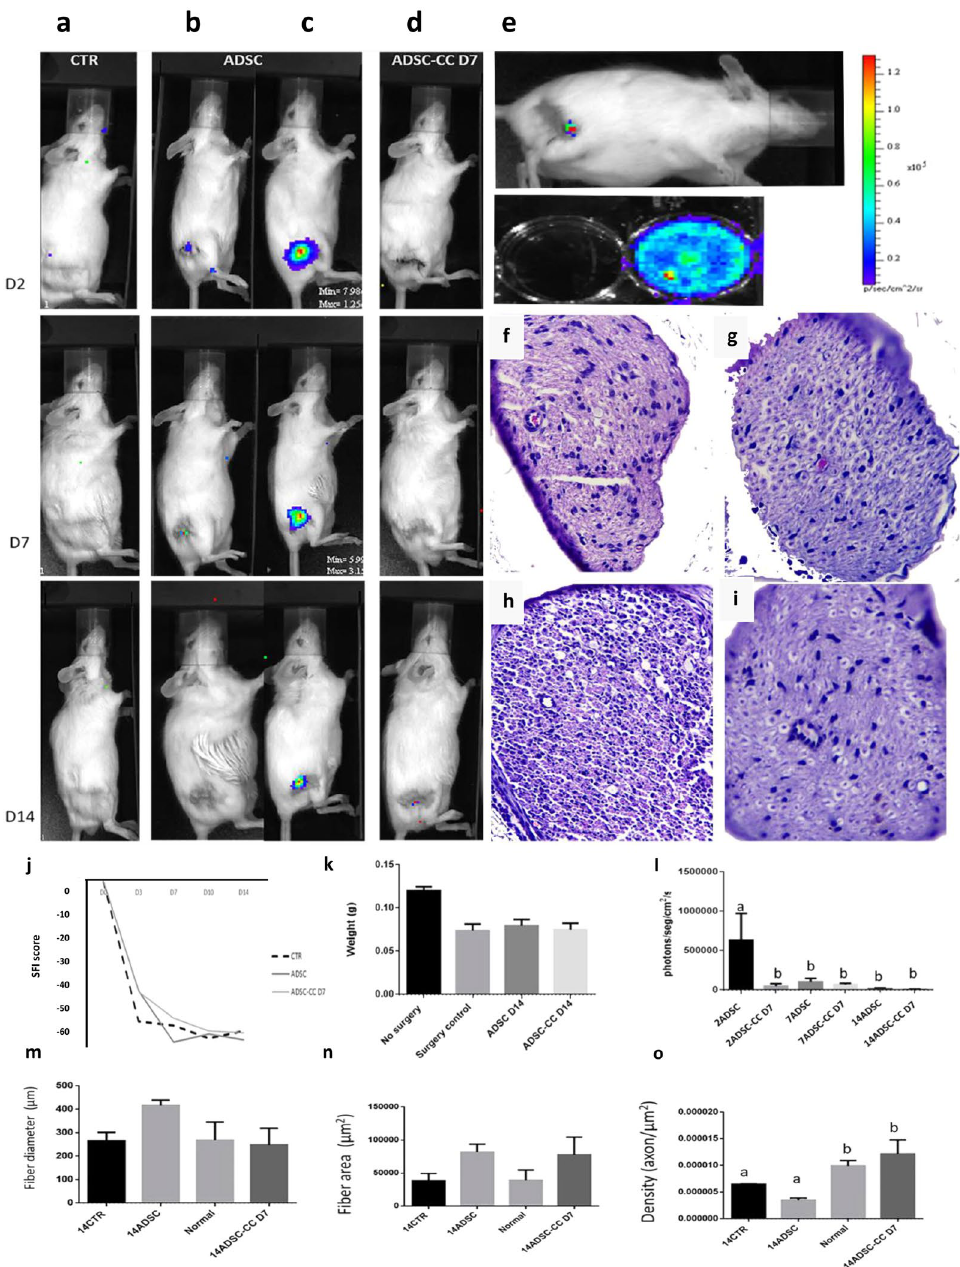
Figure 4. Co-cultured ADSC local environment improvement in vivo . ( a ) Example IVIS analysis of the CTR (control group) surgery without stem cell application group. ( b , c ) Example IVIS analysis of the surgery with ADSC application group. ( d ) Example IVIS analysis of the surgery with ADSC-CC D7 application group. ( e ) ADSCs-CC D7 were bioluminescent after the differentiation process, and after the application, few bioluminescence was acquired. Signal close to red indicate more bioluminescence and closer to blue indicate few bioluminescence. ( f ) Histology of the sciatic nerve of CTR group ( g ) Histology of the sciatic nerve of ADSC group. ( h ) Histology of the sciatic nerve of no surgery group (Normal). ( i ) Histology of the sciatic nerve of ADSC-CC D7 group. ( j ) Evaluation of sciatic nerve index (SFI) - Differences between SFI in the groups evaluated. Animals that received ADSC-CC D7 showed an improvement in SFI when compared to the other treatments, even though no statistical difference was observed (p ≤ 0.05). ( k ) On the first day of analysis (seventh postoperative day) there were marked differences between the group ADSC-CC D7 and the group ADSC on the wet weight of the gastrocnemius muscle, but over time there were no differences between the experimental groups. ( l ) Graph of IVIS analysis, there was more detectable signal on the ADSC than CTR and ADSC-CC D7. ( m , n ) There was no statistical difference between fiber diameter and ( m ) area ( n ) however there was more axon density ( o ) on the ADSC-CC D7 group than ADSC, equal value to the normal nerve without neurotmesis, Different letters within the same graph indicate statistical differences (p ≤ 0.05). The bars correspond to the means and the smaller bars are the standard error of the